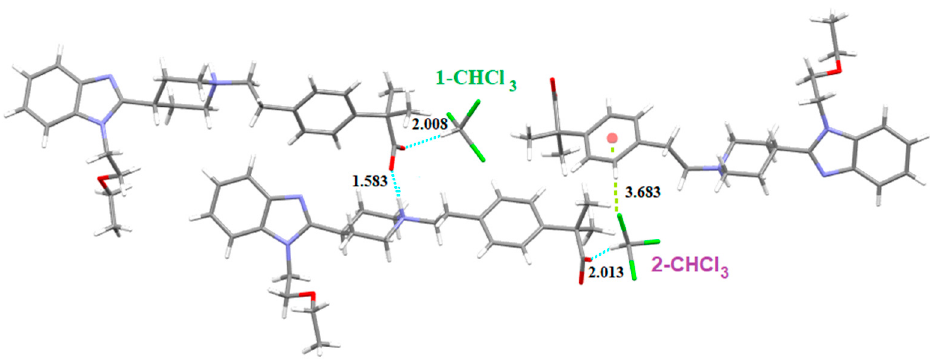
Figure 25. Intermolecular interactions (distances in Å) observed in solvate S CHCl3 .